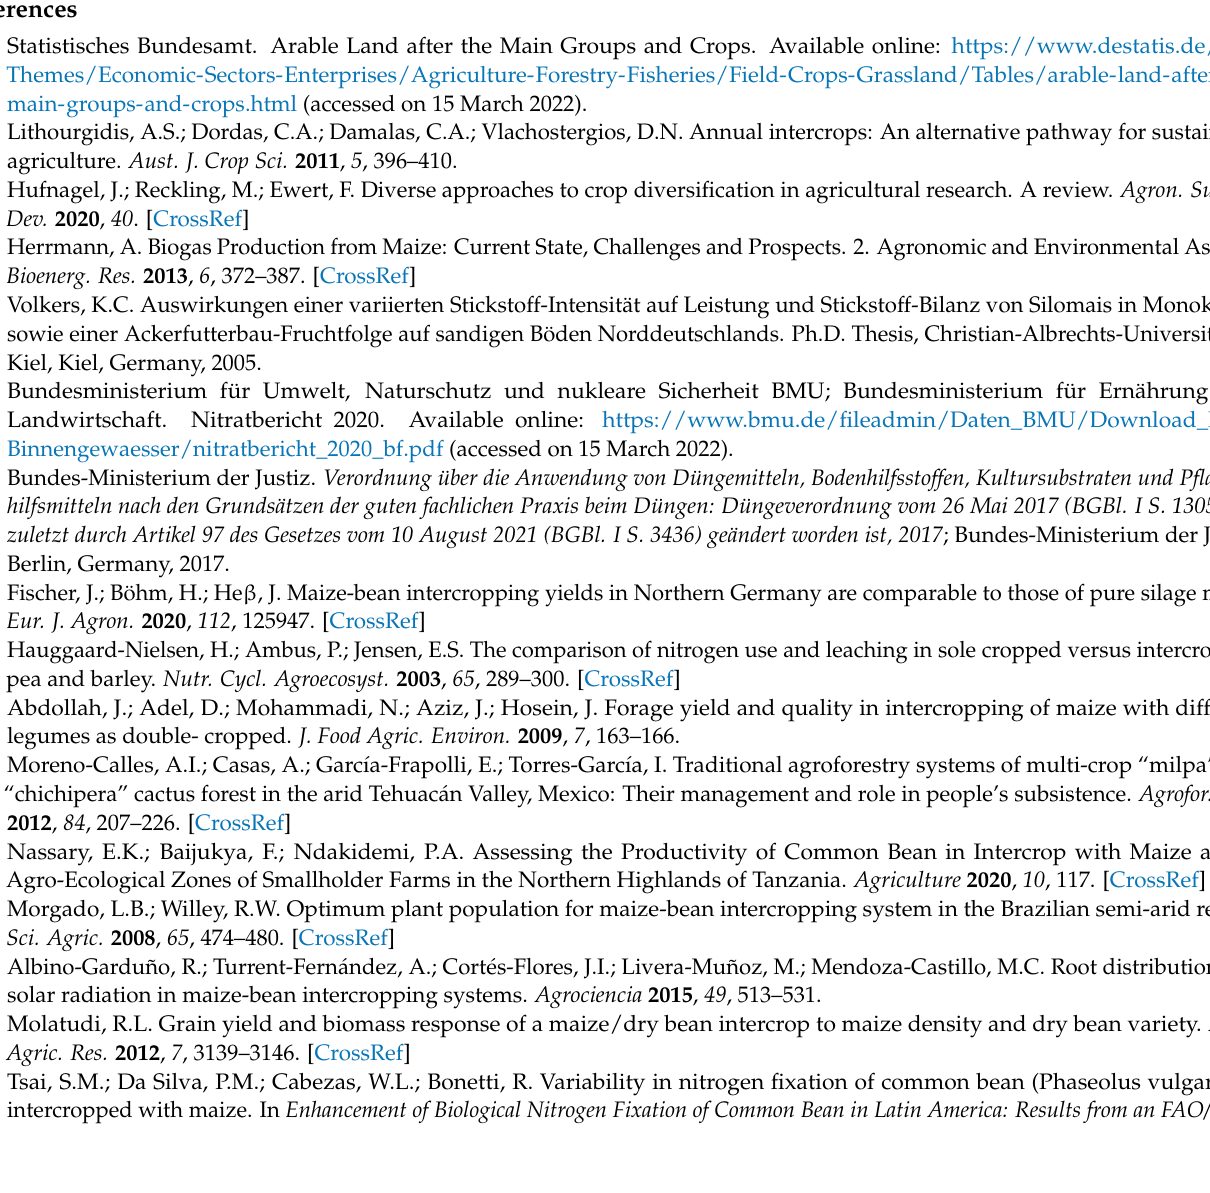
Figure A2. Proportions of maize and bean (%) in crude protein